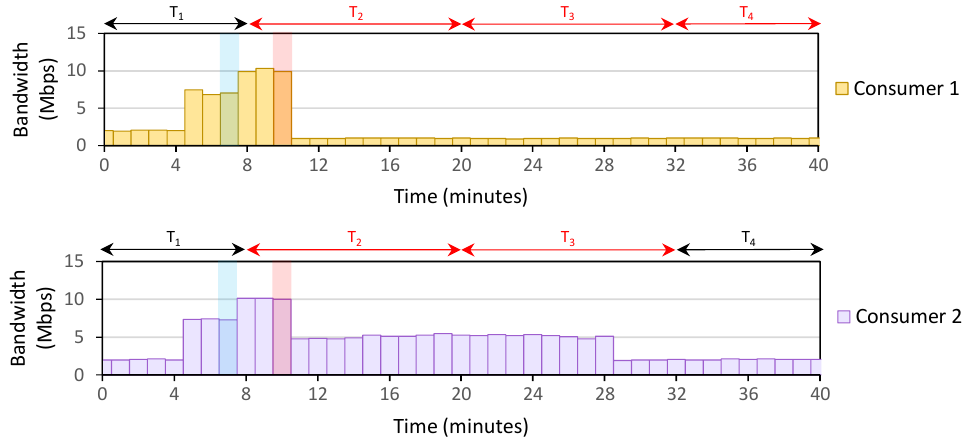
Figure 6. An example of a traffic pattern that only follows Rules 1 and 2 (Scenario 2). Green, blue, and red bars point to density changes in off-peak, normal, and peak. The red color of T n indicates the point-of-interest timeslot, where we sent the 900 MB